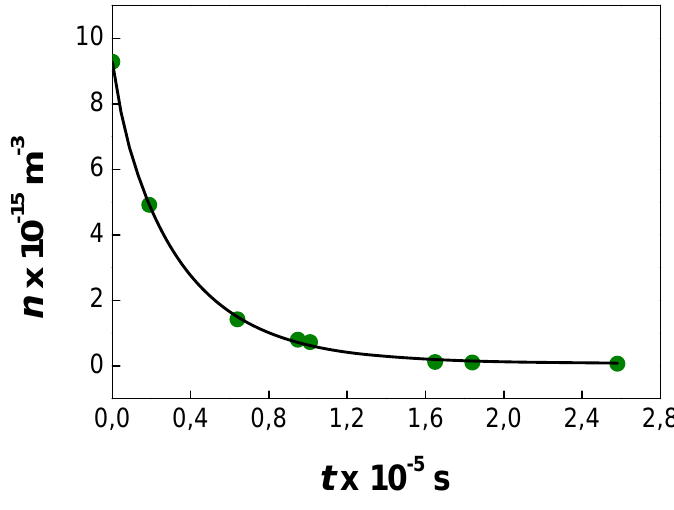
Figure 5. Variation of the number of particles as a function of time for a dodecane in water nano-emulsion stabilized with Brij 30 ( φ =